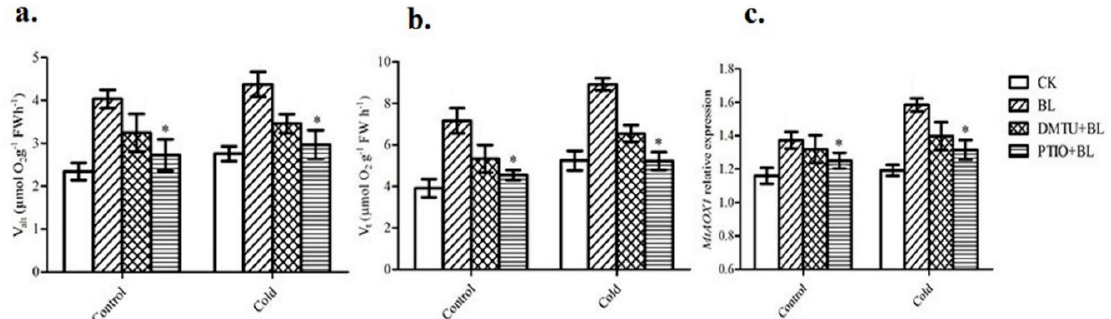
Figure 5. Effect of H 2 O 2 and NO in BRs-induced alternative respiratory pathway. Young leaves from the same position of each plant were harvested and used for the determination of alternative respiration ( V alt ) ( a ), total respiration ( V t ) ( b ), and MtAOX1 expression ( c ). Bars represent mean and standard deviation of values obtained from three biological replicates. Significant differences ( p < 0.05) are denoted by asterisks.